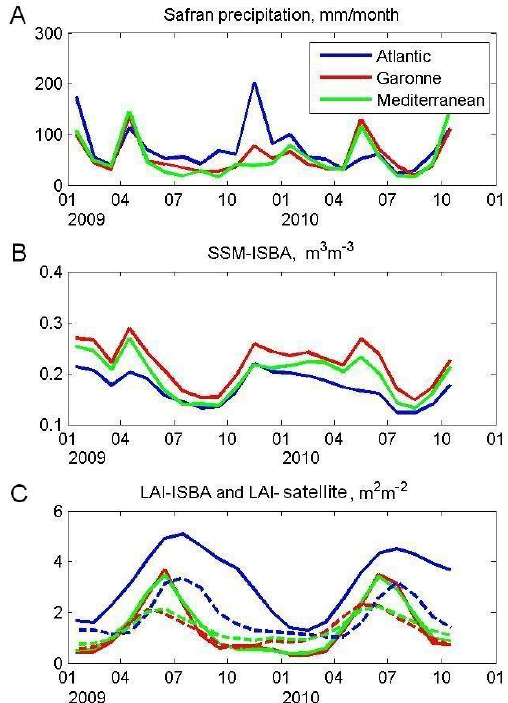
Fig. 5. Spatial and temporal variability of (A) precipitation (SAFRAN reanalysis), (B) ISBA-A-gs surface soil moisture and (C) ISBA-A-gs and satellite-derived LAI (solid and dashed lines, respectively), during the 2009–2010 period, over the three regions covered by the CAROLS Atlantic-Mediterranean transect (Atlantic, Garonne, Mediterranean). Monthly values are